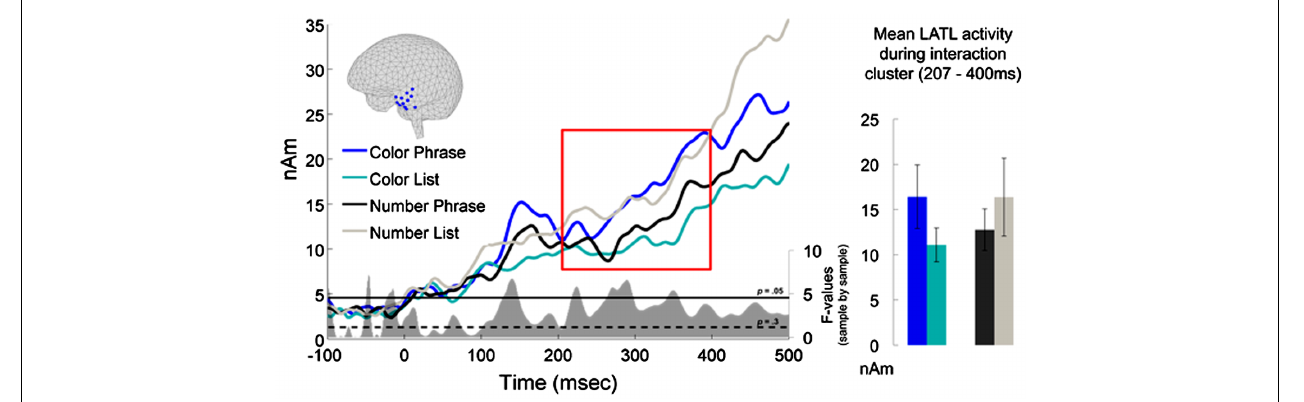
the bottom of the waveform graph, the uncorrected F -values of the interaction are plotted in gray for each millisecond, along with horizontal lines indicating p -values of 0.05 and 0.3, the latter of which served as the criterion for cluster inclusion. On the right, activation means and standard errors are plotted for the interval where the interaction was